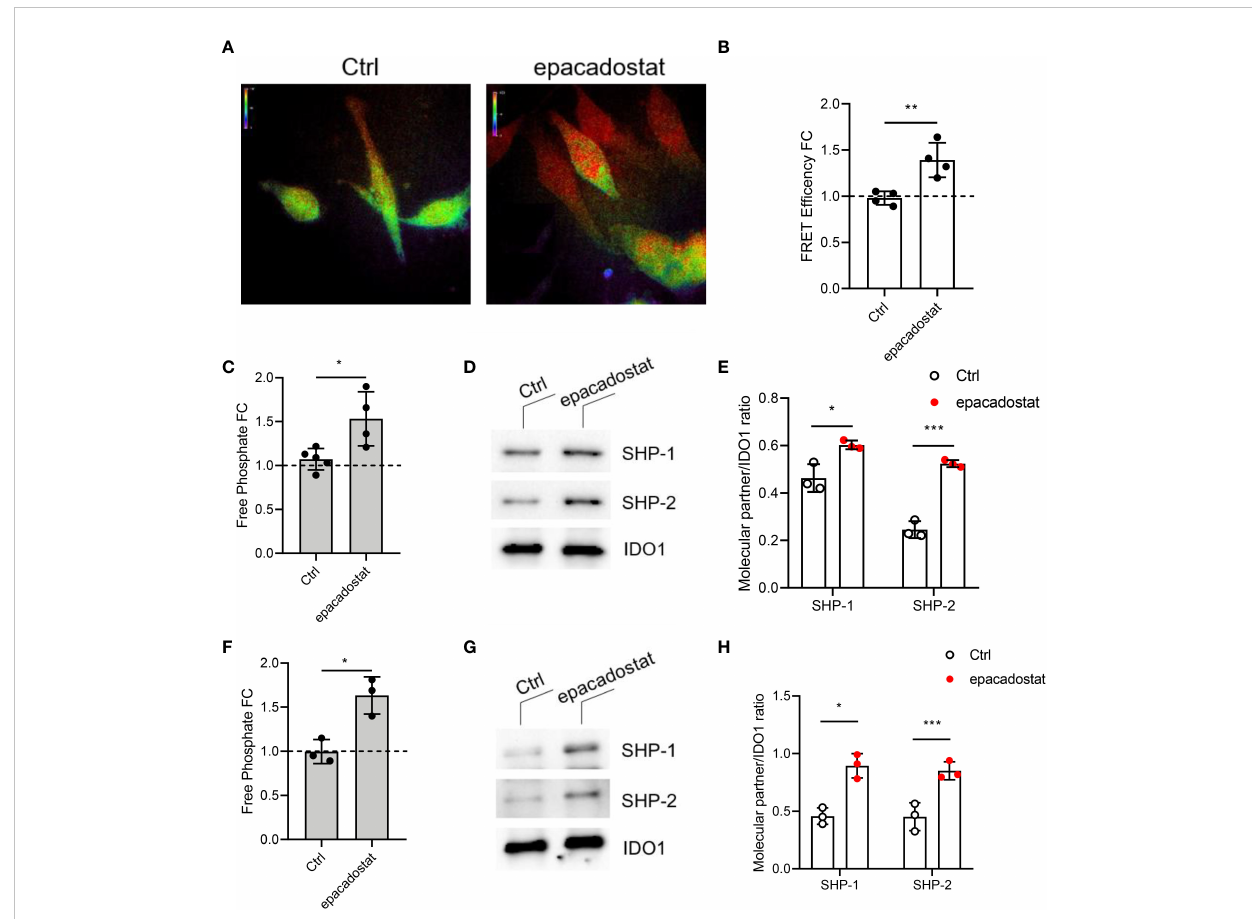
FIGURE 2 The IDO1 binding to tyrosine phosphatases SHPs is enhanced by epacadostat. (A) Representative FRET microscopy images of GFP/RFP emission in HeLa cells expressing IDO1-RFP and SHP-1-GFP fusion protein treated with epacadostat (1 m M) or the vehicle alone as a control (Ctrl). Pseudocolor scale, red corresponds to maximum interaction, while purple indicates the absence of proteins proximity. One experiment representative of two is shown. (B) FRET ef fi ciency values are presented as fold change (FC) of cells treated with epacadostat (1 m M) relative to untreated counterparts (fold change = 1, dotted line). Data ± SD are the results of two independent experiments, each performed in triplicate. (C) Phosphatase activity produced by IDO1 immunoprecipitated from P1.IDO1 cells treated with epacadostat (1 m M) or the vehicle alone as a control (Ctrl). Levels of free phosphate (pmol) generated during the incubation of a tyrosine-phosphorylated peptide with the co-immunoprecipitated IDO1 proteins from each condition were presented as a fold change (FC) relative to untreated cells (dotted line). Results are representative of three independent experiments (mean ± S.D.), each performed in triplicate. (D) Immunoblot analysis of coimmunoprecipitates from P1.IDO1 cells treated as in (C) . One experiment representative of three is shown. (E) Quantitative analysis of three independent immunoblot experiments, one of which represented in (D) . Analysis of phosphatase activity (F) , immunoblot (G) , and quantitative analysis (H) conduced as in (C – E) in cells stably expressing the IDO1 mutant H350A. One experiment representative of three is shown. Data ± SD represent the ratio of co-immunoprecipitated partner protein over immunoprecipitated IDO1. Data in (B, C, E, F, H) were analyzed with Unpaired Student ’ s t-test. *p< 0.05, **p< 0.01, ***p<